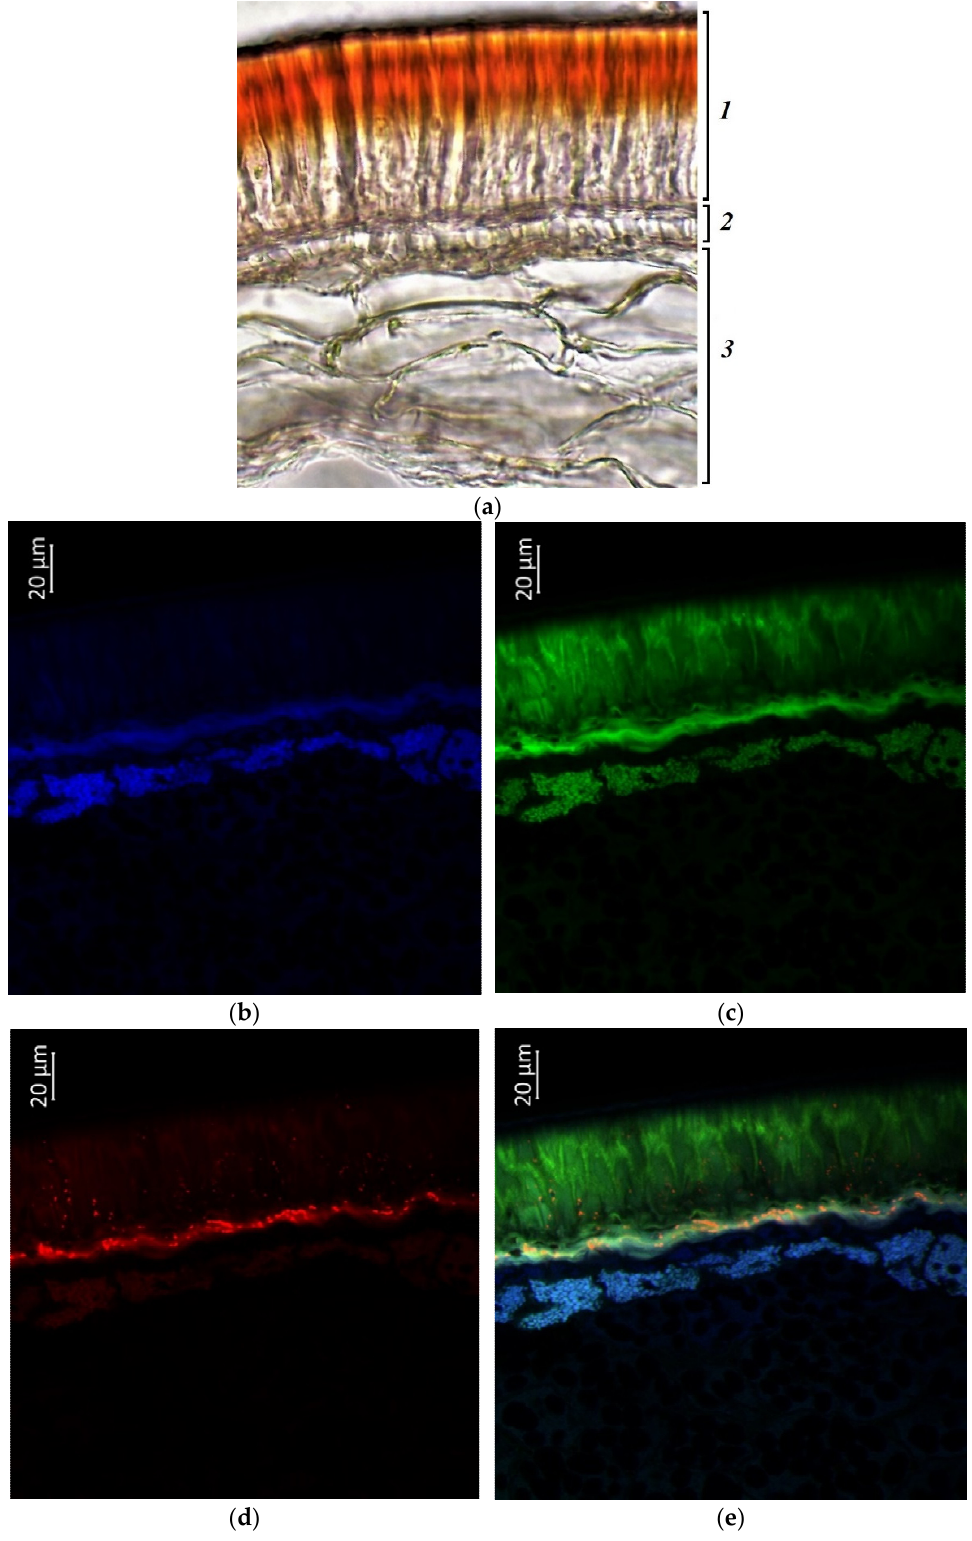
Figure 9. V. unguiculata accession k-1783: ( a )—seed coat structure, light microscopy (1—palisade layer, 2—hypoderma, 3—parenchyma); ( b – e )—transverse section of the seed, confocal microscopy, b —excitation 405 nm with the emission in 400–475 nm (blue), ( c )—excitation 488 nm with the emission in 500–545 nm (green), ( d )—excitation 488 nm with the emission in 620–700 nm (red), ( e )— merged.